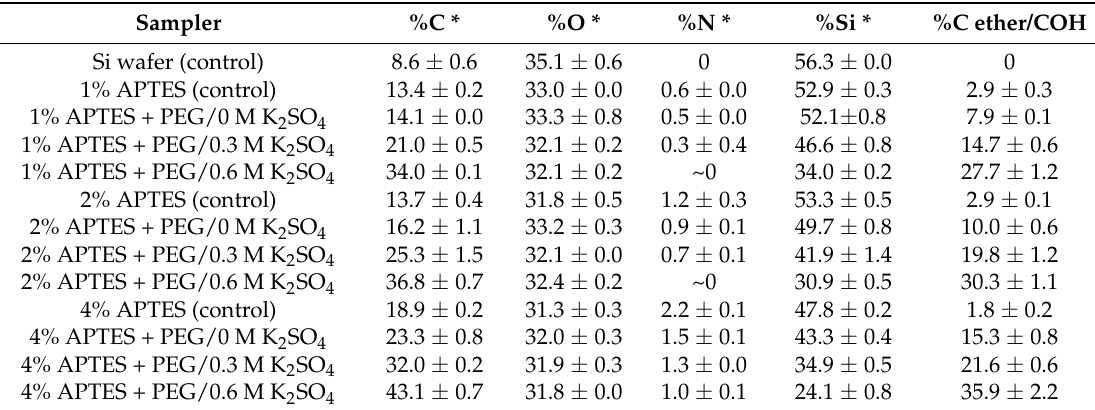
Table 1. XPS elemental compositions recorded on PEG grafted surfaces under different conditions at 60 ◦